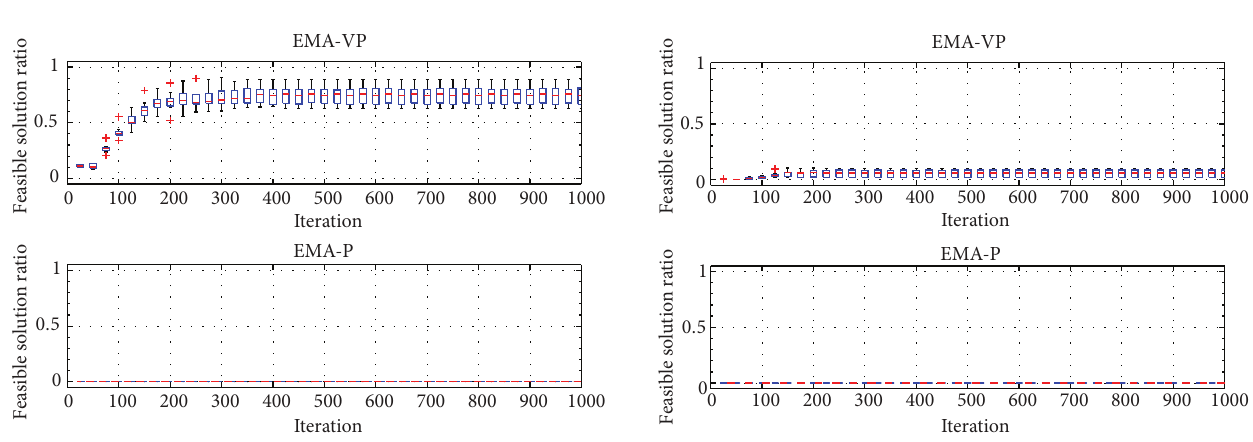
Figure 6: Ratio of feasible solutions for EMA-VP and EMA-P for RC 202.1.